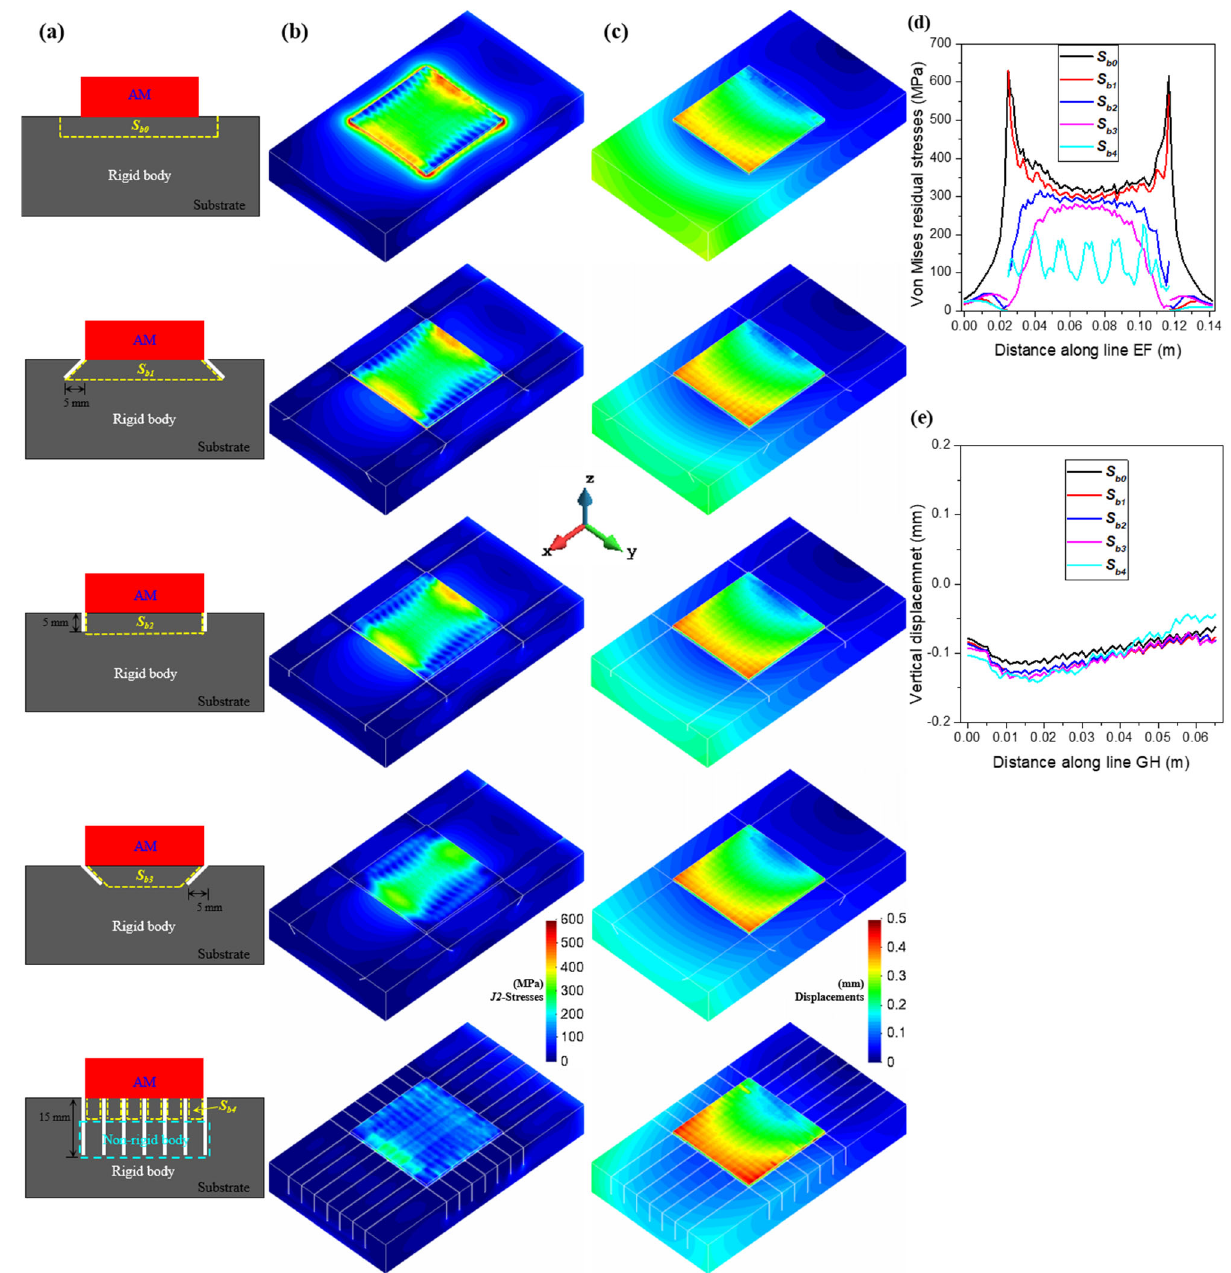
Figure 7. Square block: ( a ) different substrate designs; ( b ) von Mises stress field; ( c ) final distortions (displacements norm); ( d ) residual von Mises stresses along the EF line at the baseplate top; ( e ) vertical displacements along the GH line at the deposit top.